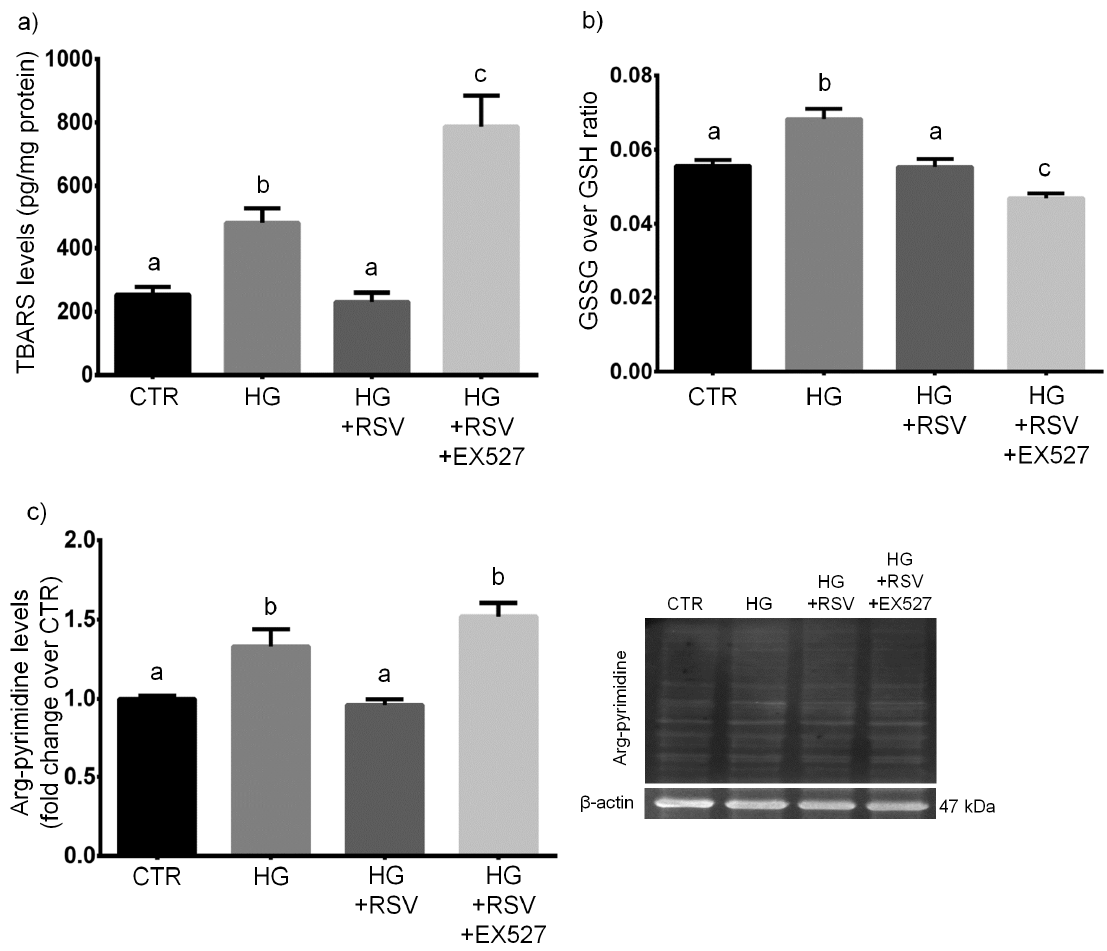
Figure 4. E ff ects of a 24-h treatment with either resveratrol alone (5 µ M) or resveratrol + EX527 (5 µ M and 13.4 µ M, respectively) combination on TBARS levels ( a ), glutathione redox balance ( b ), and arg-pyrimidine concentration ( c ) in high glucose-challenged HUVECs. Representative blots are also shown ( c ). Data are expressed as means and S.E.M. Abbreviations: CTR—vehicle; HG—high glucose; HG + RSV—high glucose + resveratrol; HG + RSV + EX527—high glucose + resveratrol + EX527; GSH—reduced glutathione; GSSG—glutathione disulfide; TBARS—thiobarbituric acid-reactive substances. Means sharing the same letter are not significantly di ff erent from each other (one-way ANOVA and Tukey’s multiple comparisons test): Panel ( a ): a vs. b, p < 0.05; b vs. c, p < 0.05; a vs. c, p < 0.001 ( N = 4). Panel ( b ): a vs. b, p < 0.001; b vs. c, p < 0.001; a vs. c, p < 0.05 ( N = 8). Panel ( c ): a vs. b, p < 0.05 ( N =